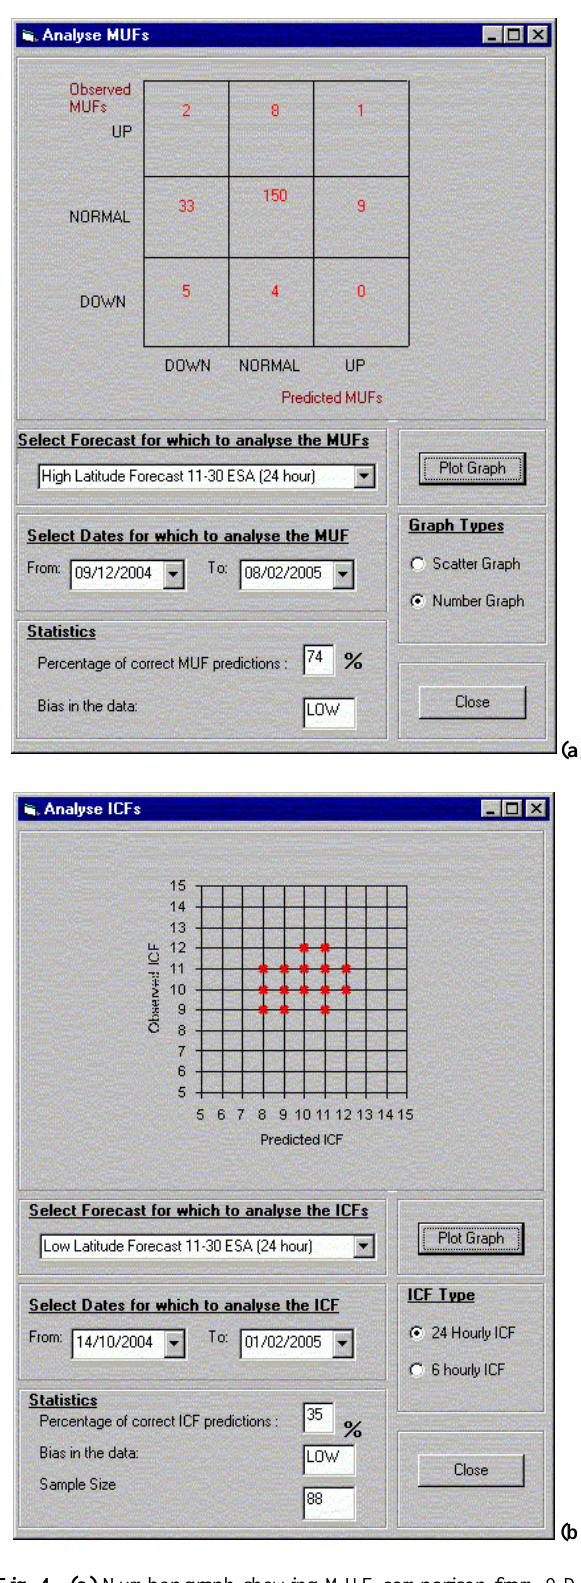
Fig 6-2 - Scatter plot showing ICF comparison from 14 th Oct. 2004 to 1 st Feb. 2005 Fig. 4. (a) Number graph showing MUF comparison from 9 De- cember 2004 to 8 February 2005; (b) Scatter plot showing ICF com- parison from 14 October 2004 to 1 February 2005